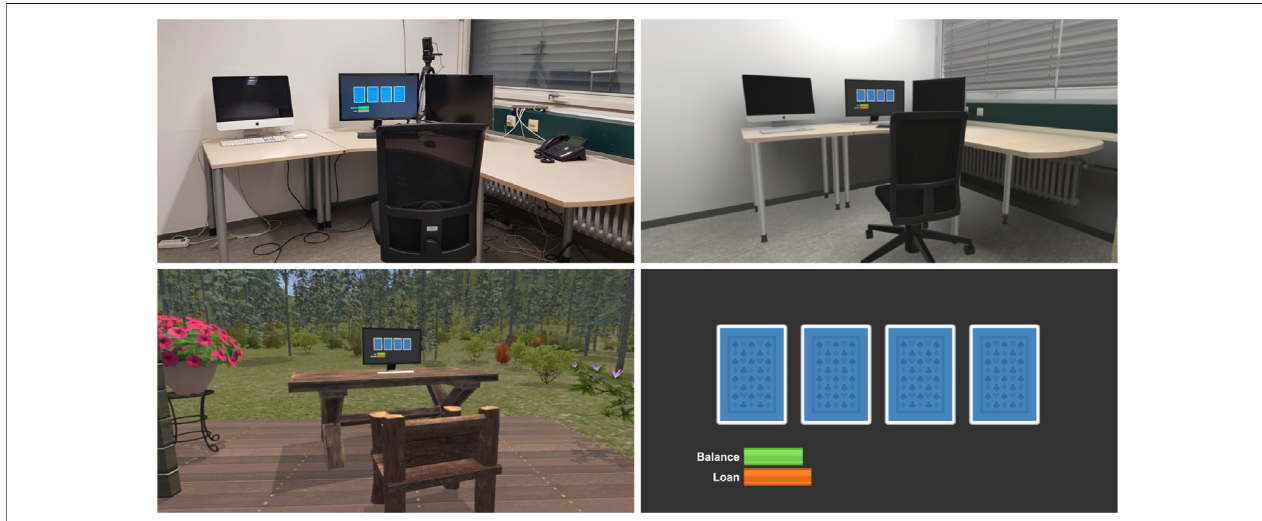
FIGURE 1 | Comparison of ourthree IGT versions. Top left: IGT played on desktop in the laboratory. Top right: IGT played in the virtual laboratory. Bottom left: IGT played in the virtual forest. Bottom right: IGT user interface for all versions.